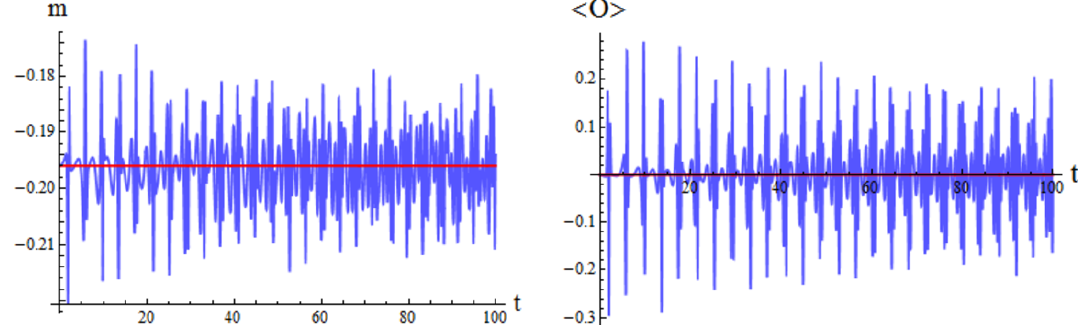
Figure 3 . Energy density (left, blue) and vev (right, blue) for the (cid:15) = 1 ; (cid:27) = 0 : 1 Gaussian perturbation of a pumping solution with (cid:11) o = 1. Red curves denote the initial values of each plotted quantity. In this simulation, the absolute error in the Ward identity is bounded by 10 (cid:0) 4 for a grid resolution N = 2 11